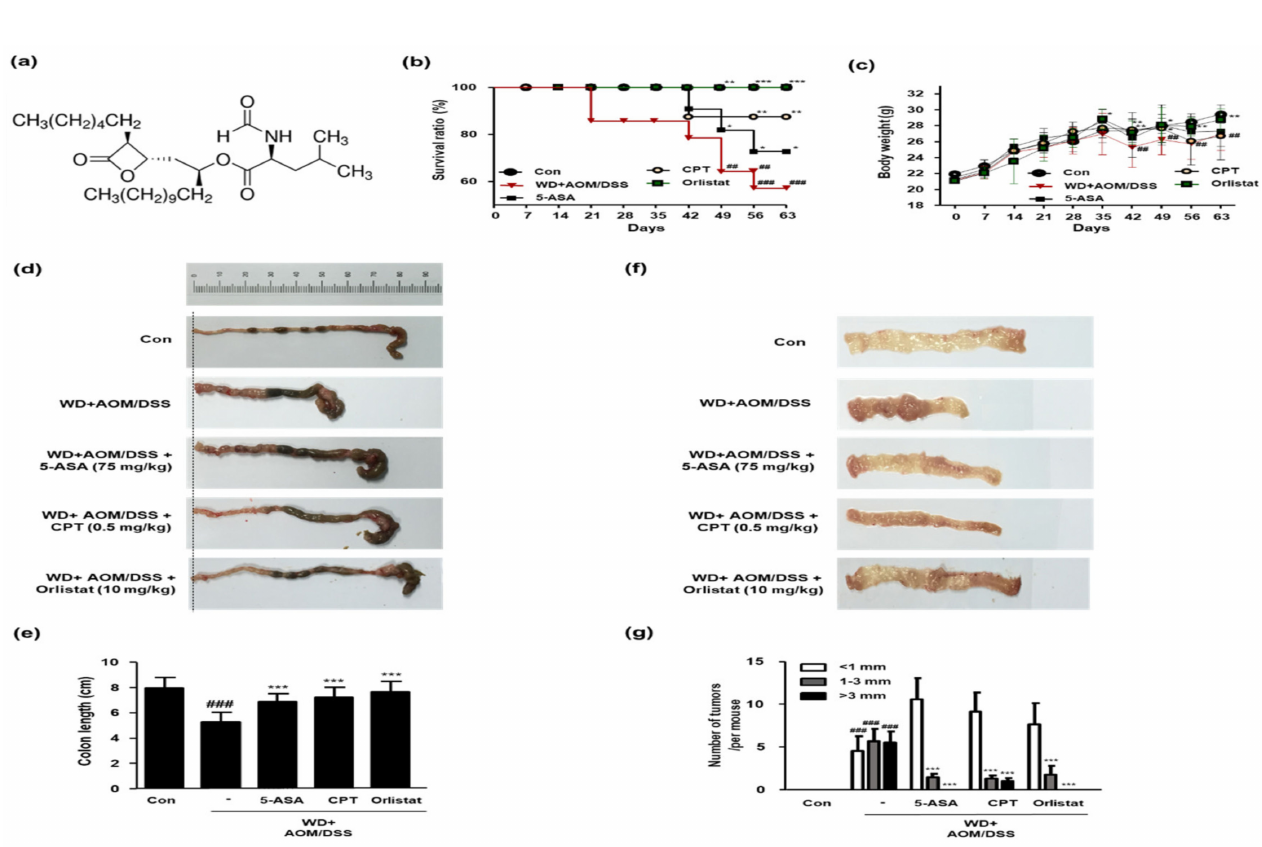
Figure 3. Effect of orlistat on the development of CAC in WD-driven CAC mice. ( a ) Orlistat structure; ( b ) survival ratio for each group. Data were analyzed by Kaplan–Meier survival analysis ( n = 11); ( c ) body weight for each group ( n = 11); ( d ) representative photographs of colonic lengths from each experimental group. ( e ) Colon length in each animal was measured between the cecum and proximal rectum. ( f ) Representative photographs of numbers of tumors in each experimental group; ( g ) number of tumors in each group. Results are the means ± SD ( n = 6); ## p < 0.01 and ### p < 0.001 when compared to Con; * p < 0.05, ** p < 0.01 and *** p < 0.001 when compared to the WD +